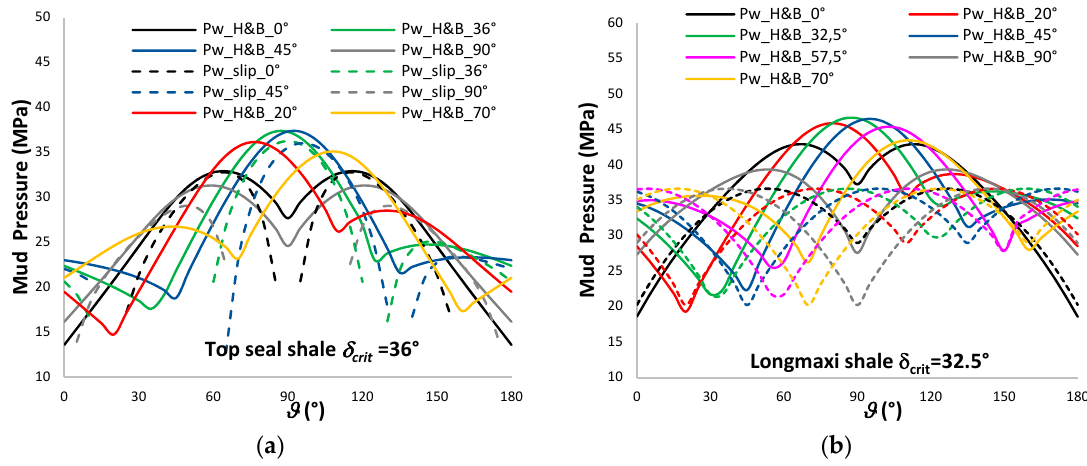
Figure 13. Mud pressures calculated at different δ . ( a ) Comparison between mud pressures calculated with the weakness plane model and the Hoek and Brown criterion. In situ stresses: σ MAX = 45 MPa, σ min = 35 MPa, P f = 20 MPa. ( b ) Effect of the in situ stress anisotropy σ MAX = 70 MPa, σ min = 50 MPa, P f = 45 MPa (solid lines); and σ MAX = 50 MPa, σ min = 50 MPa, P f = 45 MPa (dotted lines).